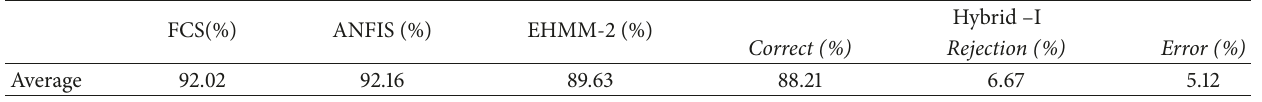
Table 5: The results of Hybrid-I.